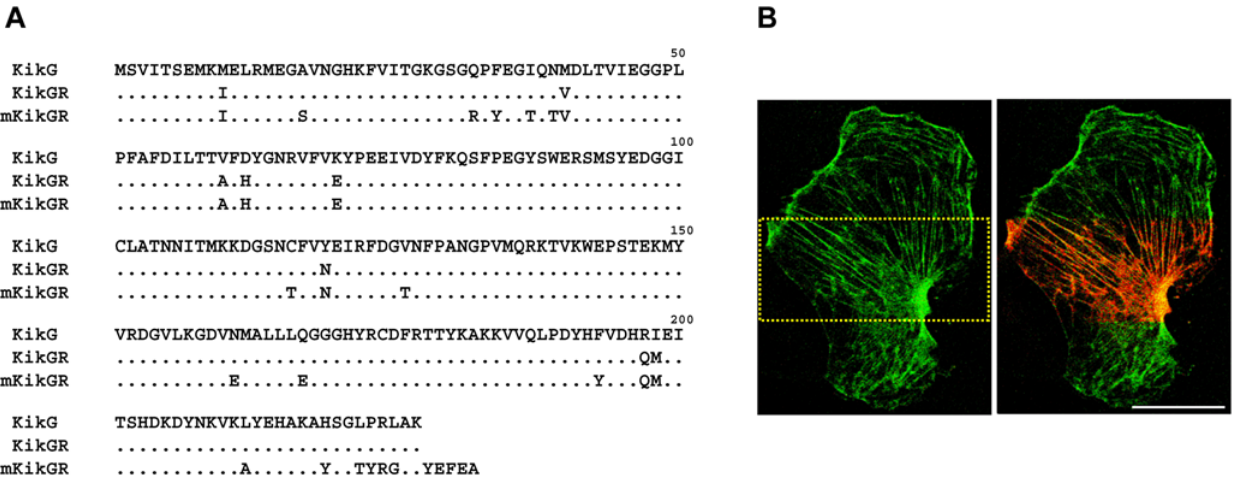
Figure 1. Construction of mKikGR. (A) Amino-acid sequences for KikG, KikGR, and mKikGR. (B) Rat primary astrocyte expressing mKikGR- b actin. Images show before (left) and after (right) local photoswitching by irradiating 405 nm laser over the yellow-boxed region. Cells are cultured at 37 u